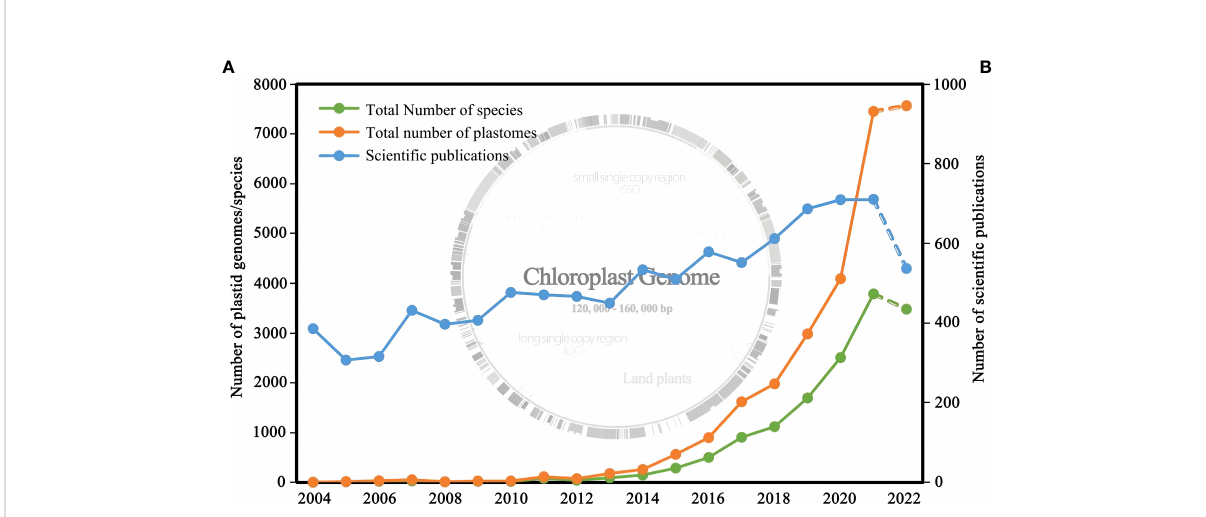
FIGURE 1 (A) Number of plastid genomes of land plants released and the corresponding number of species from 2006 to 2022; (B) Number of research articles published from 2006 to 2022. Genomic data were obtained from NCBI ( fi lter criteria: land plant, 120,000-160,000 bp, chloroplast), and the publication data were obtained from Web of Science ( fi lter criteria: plant, phylogeny,